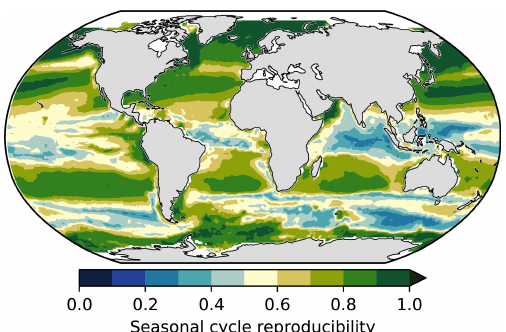
Figure 12. The seasonal cycle reproducibility of CSIR-ML6 p CO 2 , which is a correlation of detrended p CO 2 with its own climatology – the larger the correlation, the stronger the reproducibility of the seasonal cycle (method from Thomalla et al.,